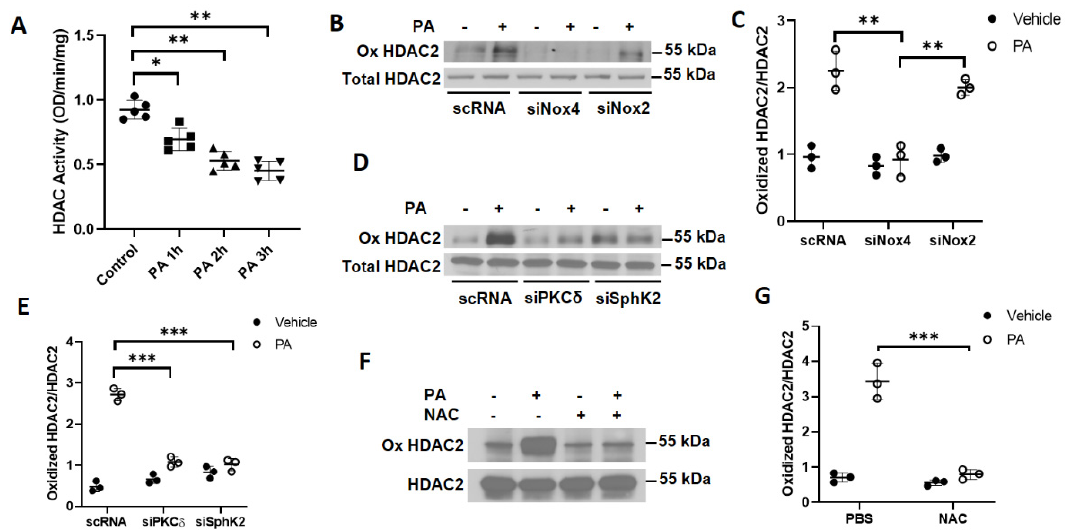
Figure 7. P. aeruginosa inhibits HDAC2 activity via PKC δ - and NOX4-dependent oxidation of HDAC2. ( A ) Primary human bronchial epithelial cells (HBEpCs) were treated with heat-inactivated PA (1 × 10 8 CFU/mL) for 1, 2, and 3 h, and nuclei were isolated as described under Methods. Total HDAC activity in the nuclear fraction was determined and value expressed as means ± SD of three independent experiments. ** p < 0.01 * p < 0.05. ( B , C ) HBEpCs cells were transfected with scRNA , siNox2 , or siNox4 (50 nM) for 48 h prior to exposure to heat-inactivated PA (1 × 10 8 CFU/mL) for 2 h. Cells were trypsinized, and nuclei were isolated as described in Experimental Procedure. Nuclear lysates (~500 µ g protein) were subjected to immunoprecipitation with anti-histone deacetylase (HDAC) 2 antibody and oxidized HDAC2 (Ox HDAC2) was detected in the immunoprecipitates by Western blotting by probing with the OxyBlot oxidized protein detection kit. Shown is a representative blot, and quantification of the band intensity was carried out by the Image J program. Values are means ± SD of three independent experiments. ** p < 0.01. ( D , E ) HBEpCs cells were transfected with scrambled, PKC δ , or Sphk2 siRNA (50 nM) for 48 h prior to exposure to heat-inactivated PA , as described above. Lysates (~500 µ g protein) from isolated nuclei were subjected to immunoprecipitation with anti-HDAC2 antibody and oxidized HDAC2 was detected. Shown is a representative blot, and quantification of the band intensity was carried out by the Image J program and normalized to total HDAC2. Values are means ± SD of three independent experiments. *** p < 0.005. ( F , G ) HBEpCs cells were pretreated N -acetyl cysteine (NAC) (1 mM) for 30 min prior to PA (1 × 10 8 CFU/mL) challenge for 2 h. Nuclei were isolated and oxidized HDAC2 (Ox HDAC2) was detected by Western blotting as described above. Values are means ± SD of three independent experiments. *** p < 0.005.